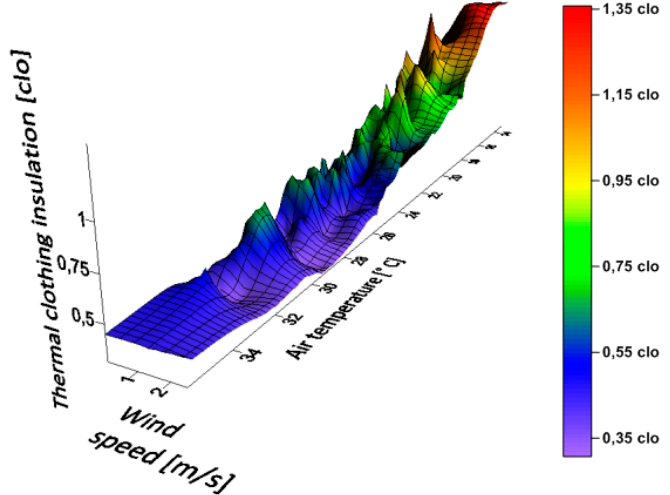
Figure 3. Values of the thermal clothing insulation with respect to wind velocity and air temperature.